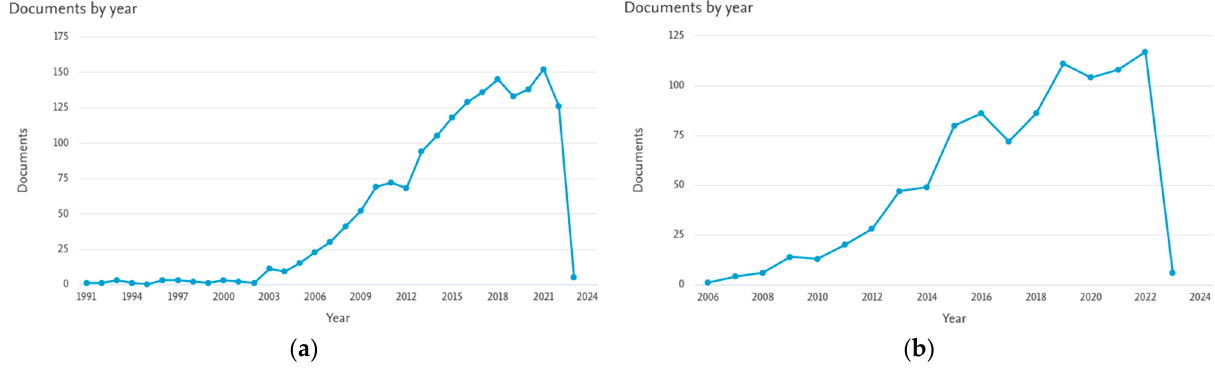
Figure 21. Trend of scientific papers concerning label-free immunosensors and aptasensors. ( a ) Survey of immunosensors according to the keywords “label free immunosensor” in Scopus database. ( b ) Survey of aptasensors according to the keywords “label free aptasensors” in Scopus database. Both surveys are obtained by searching within article title, abstract and keywords.